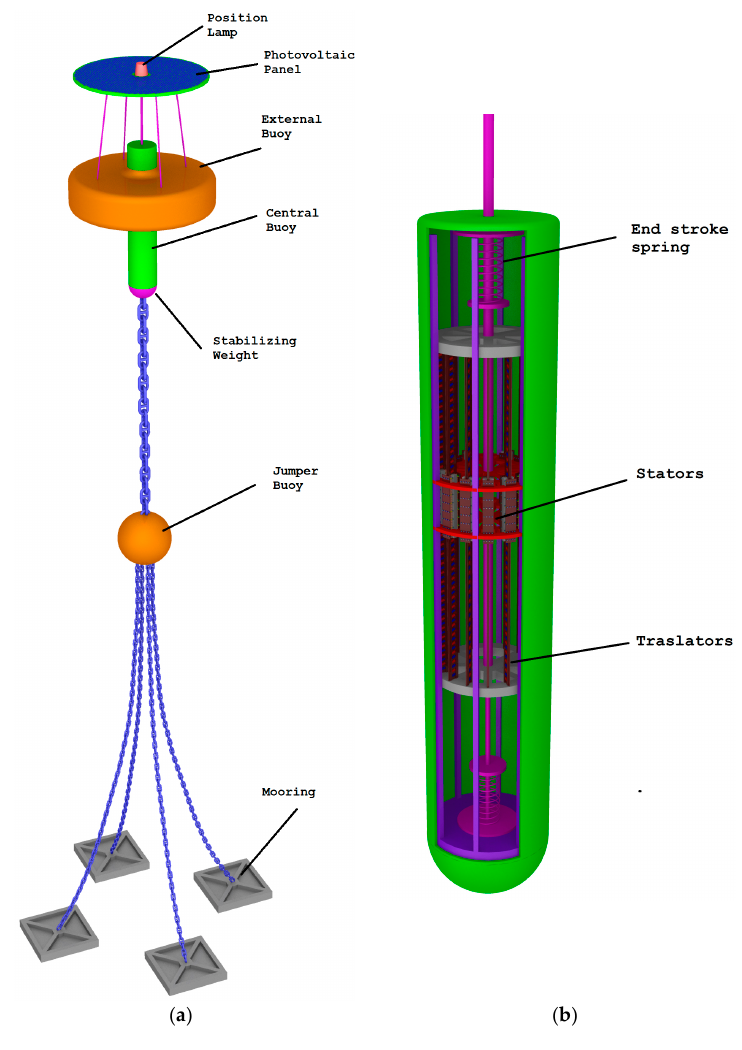
Figure 10. ( a ) External and ( b ) internal views of the Department of Energy and Information engineering and Mathematical model (DEIM) point absorber.